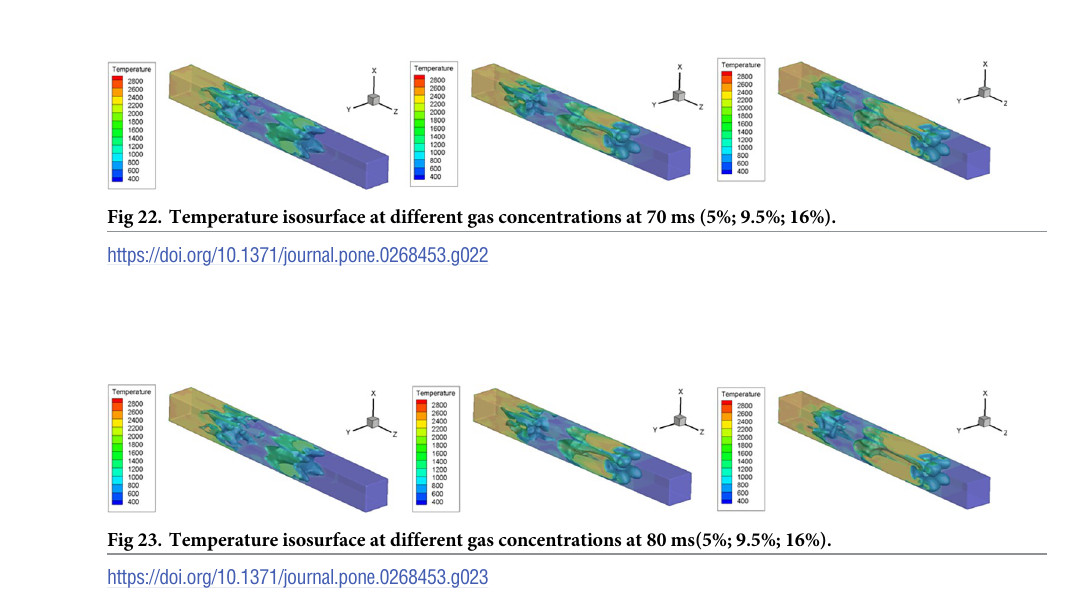
PLOS ONE | https://doi.org/10.1371/journal.pone.0268453 May 26,